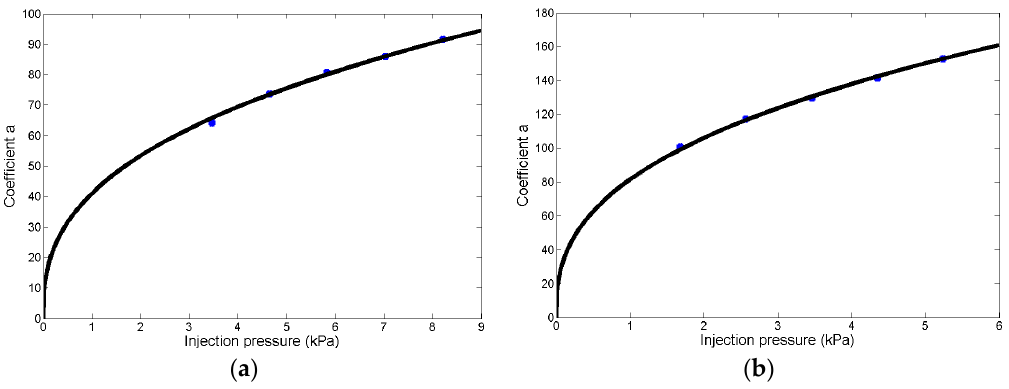
Figure 9. The coefficient a . ( a ) The coefficient a follows a power law versus injection pressure (the blue points), which is fitted with Equation (7) (the black curve), with a goodness of fit of 0.99. The radius of the micropipette opening is 3.5 μ m; ( b ) the coefficient a follows a power law versus injection pressure (the blue points), which is fitted with Equation (9) (the black curve), with a goodness of fit of 0.99. The radius of the micropipette opening is 6.9 μ m.